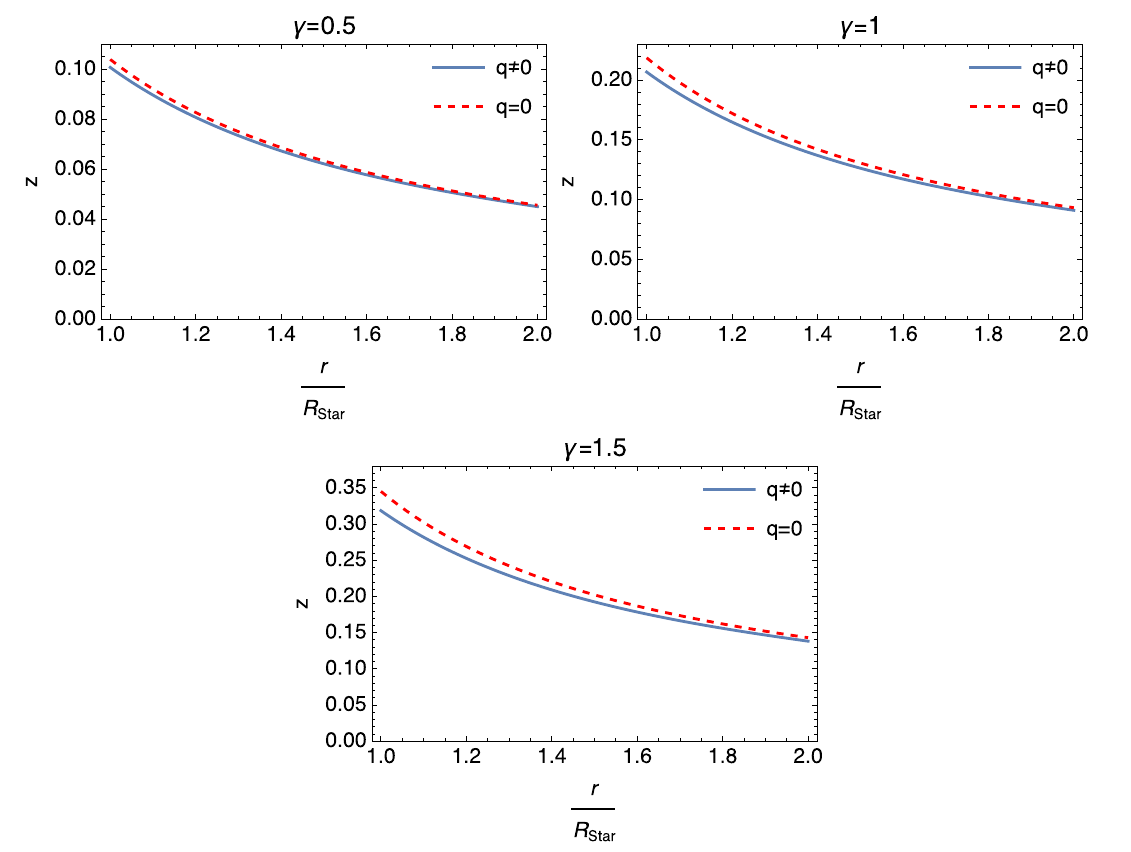
Fig. 14 The graphs show the variation in the redshift z versus r for the compact object 4U1538-52. The plots are generated for static charged R Star ( q (cid:8)= 0 ) and static uncharged ( q = 0 ) cases. Variation for each case are shown on the same graph for different values of deformation parameter